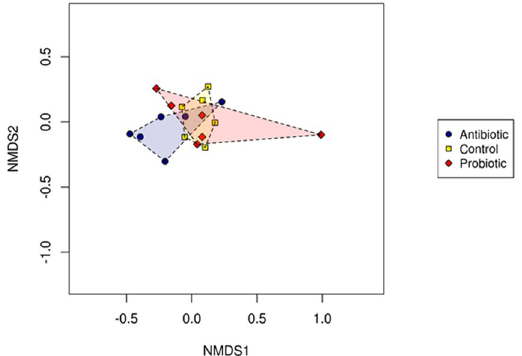
Figure 6. Non-metric multidimensional scaling (NMDS) ordination plot of bacterial communities of the different treatment groups (i.e. multi-strain probiotic, antibiotic combination and control) based on the Bray- Curtis distance.